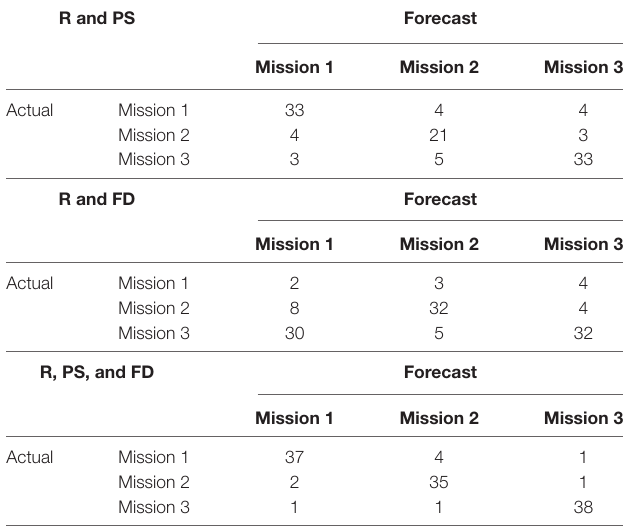
TABLE 9 | Comparison of results of three combinations.